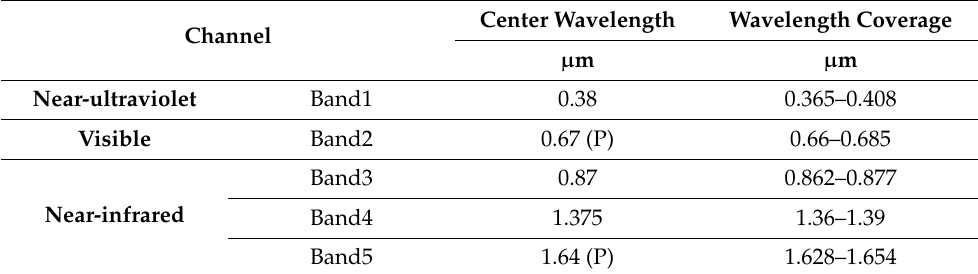
Table 1. Wavelength and wavelength range of each CAPI channel. Center Wavelength Wavelength Coverage Channel µ m µ m Near-ultraviolet Band1